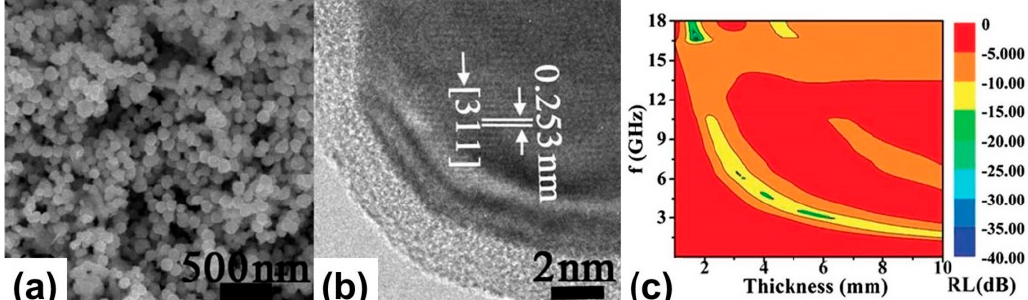
Figure 5. ( a ) SEM image; ( b ) HRTEM (High Resolution Transmission Electron Microscopy) image; and ( c ) two-dimensional (2D) representation of the R L of Fe 3 O 4 –PANI nanoparticles. Reprinted with permission from Reference [78].